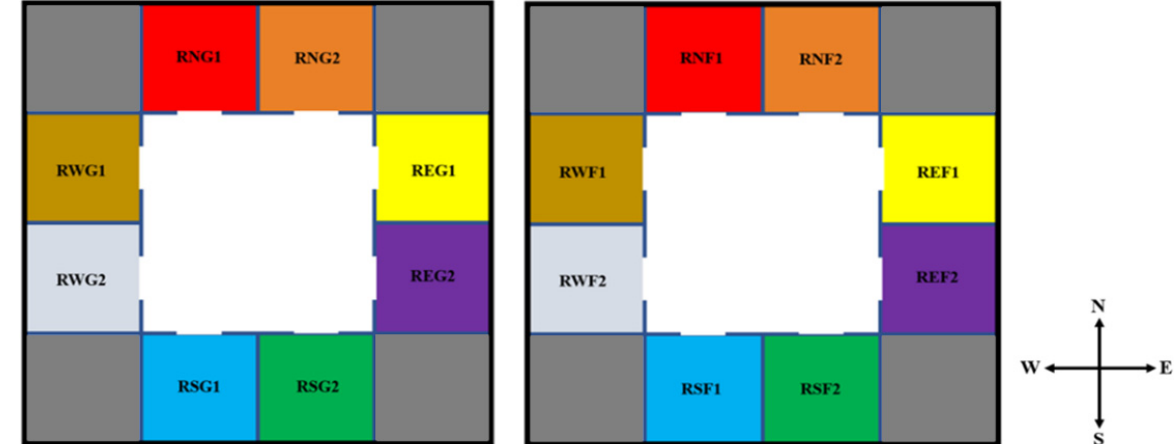
Figure 3. The layout of the rooms on each floor (R—Room, N—North, W—West, S—South, E—East, G—Ground floor, F—First floor).